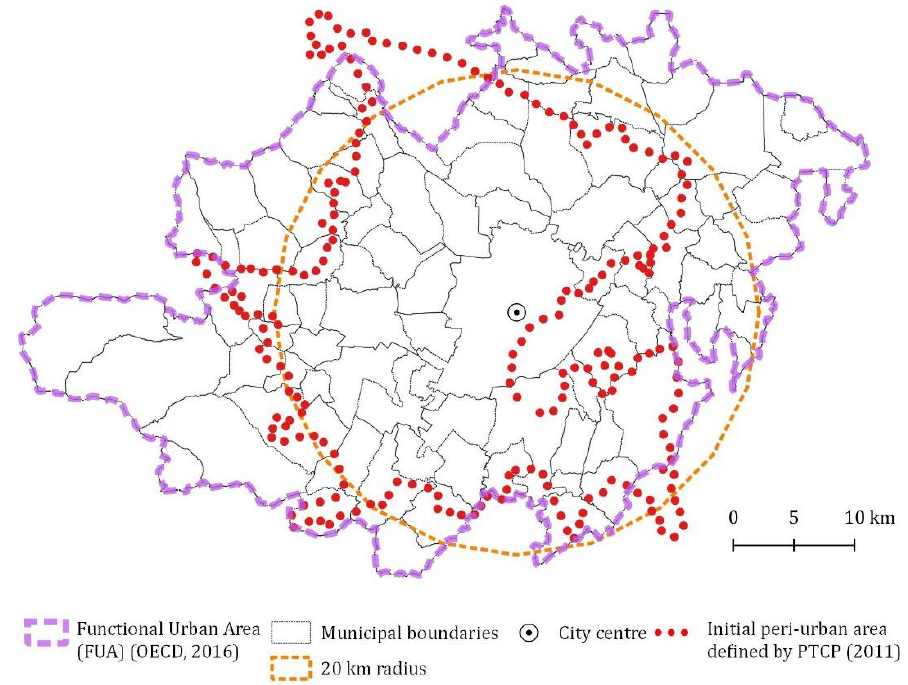
Figure 1. Identifying indispensable conditions for peri-urbanization in the TMA.